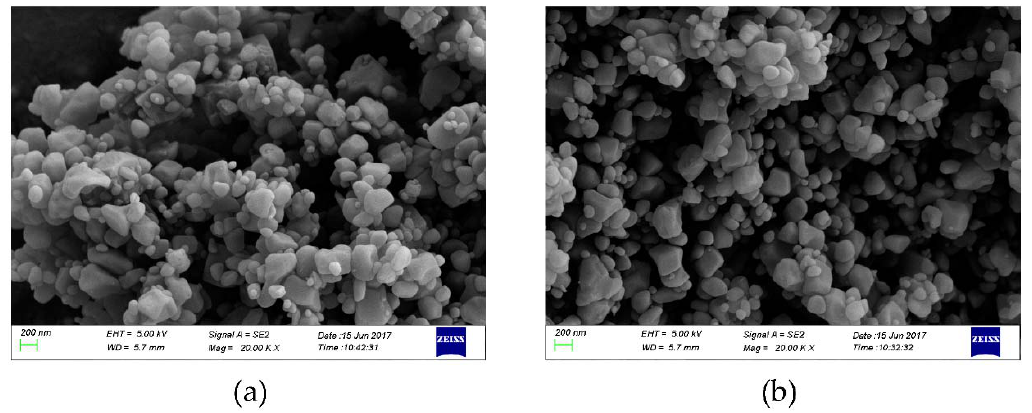
Figure 11. Comparison of the SEM images of fresh ZIF ‐ 8 and recycled ZIF ‐ 8 from a ZIF ‐ 8/water ‐ glycol slurry after the separation of C 3 H 6 /H 2 . ( a ) fresh ZIF ‐ 8; ( b ) recycled ZIF ‐ 8.